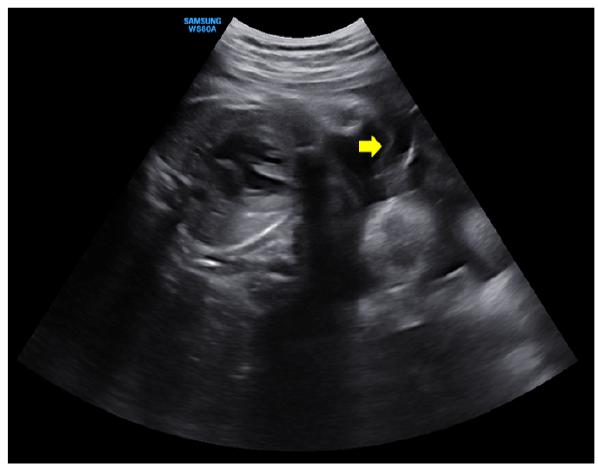
Figure 1. An ultrasonographic examination at 6 days before visiting emergency room. The intertwine membrane (yellow arrow) was well seen, and the amniotic fluid of both fetuses was normal. Initially, the patient’s vital signs were stable and as follows: blood pressure, 125/75 mmHg; pulse rate, 98 beats/min; respiratory rate, 20 breaths/min; body temperature, 36.6 °C; and oxygen saturation, 99%. Cervical examination revealed 10% cervical dilatation, 50% effacement, and − 2 fetal station. Ultrasonography showed that the first fetus was located on the left side of the mother in a vertex presentation and that the fetal heart rate was 150–160 beats/min with good fetal motion, but the amniotic fluid volume index (AFI) was more than 30 cm, showing polyhydramnios. The second fetus was located on the right side of the mother and exhibited a heart rate of 70–80 beats/min and consistent bradycar ‐ dia with a breech presentation, showing oligohydramnios (Figure 2). No evidence of pla ‐ cental abruption was noted. Continuous fetal monitoring was performed while preparing was noted as 30–40 mmHg of uterine contractions at 5–6 ‐ min intervals.